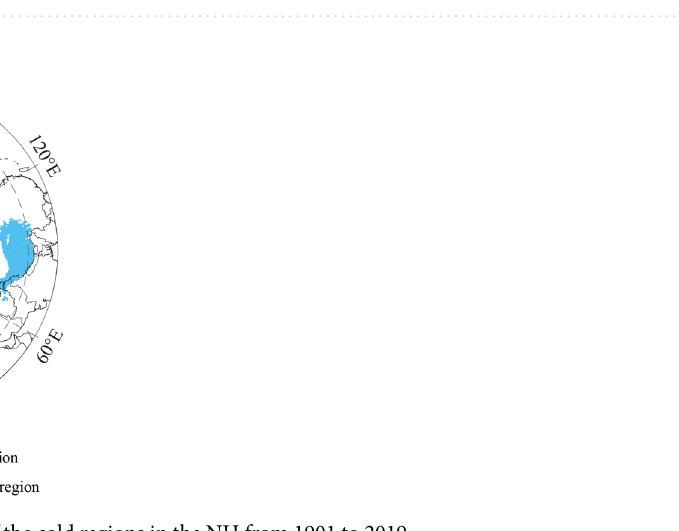
Figure 1. ( a ) Interannual and ( b ) tri-decadal variations and ( c ) anomalies in the spatial extent of the cold regions in the NH from 1901 to 2019.